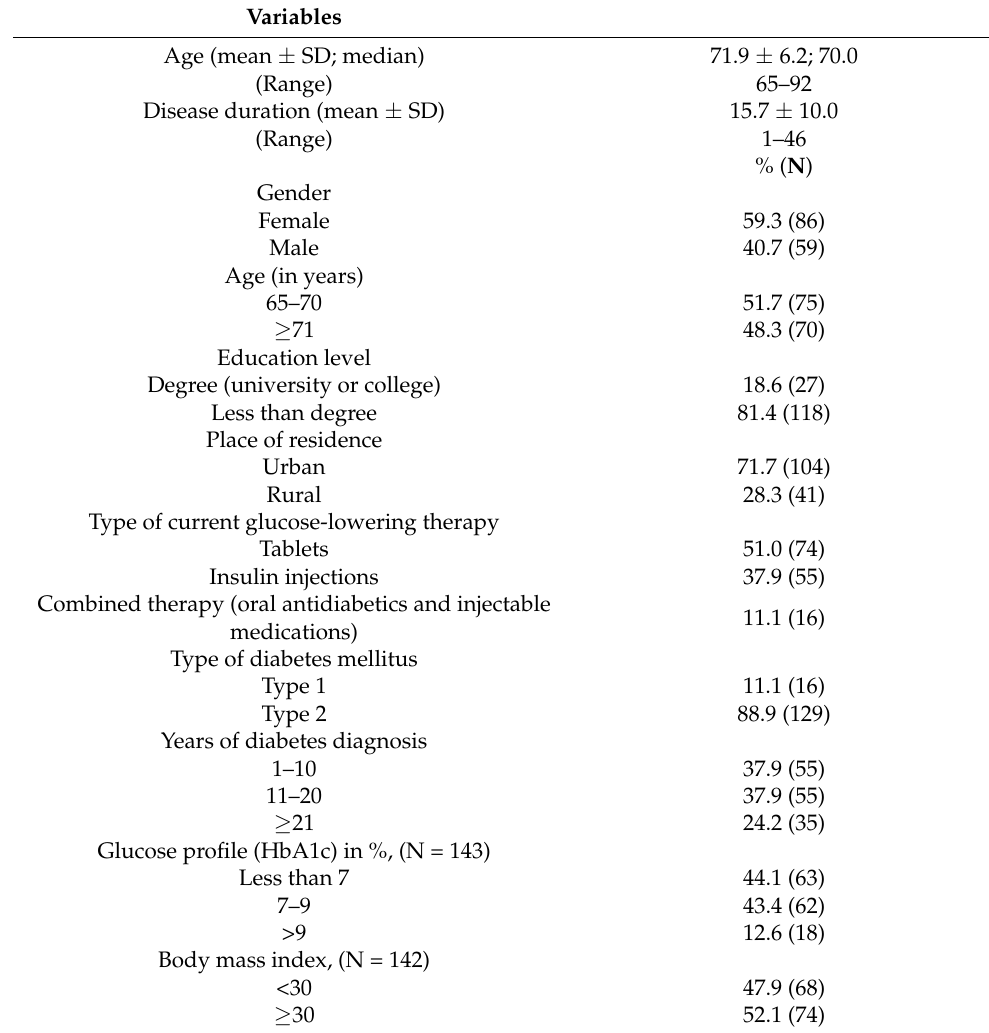
Table 2. Characteristics of the patient sample (N =